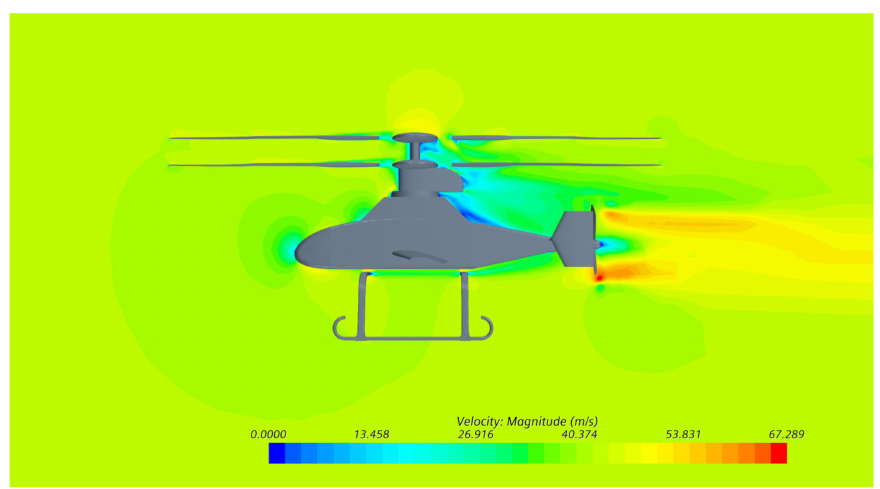
Figure 27. Velocity contour of a compound coaxial helicopter in forward flight.